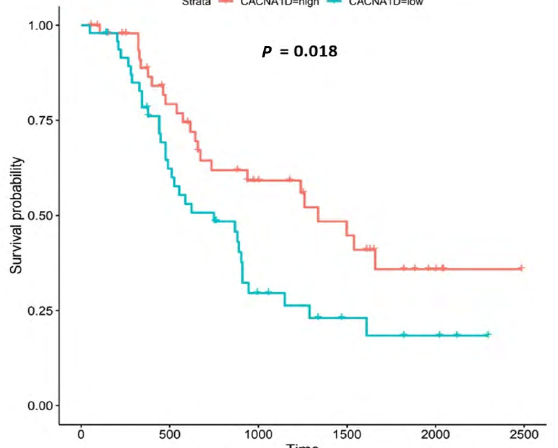
Figure 6. Kaplan-Meier survival plot for CACNA1D . Kaplan-Meier, survival plot (OCCAMS data) for CACNA1D . The comparison was made between patients with high CACNA1D -expression (TPM above the upper quartile) and those with low expression (TPM below the lower quartile). The plot shows survival probability with increasing time in days. A log-rank P -value of < 0.05 was considered statistically significant. An adjustment for MOT (FDR Method [83 ]) was